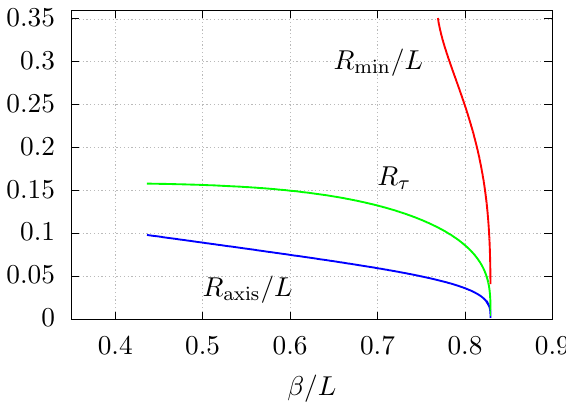
, the euclidean circle axis